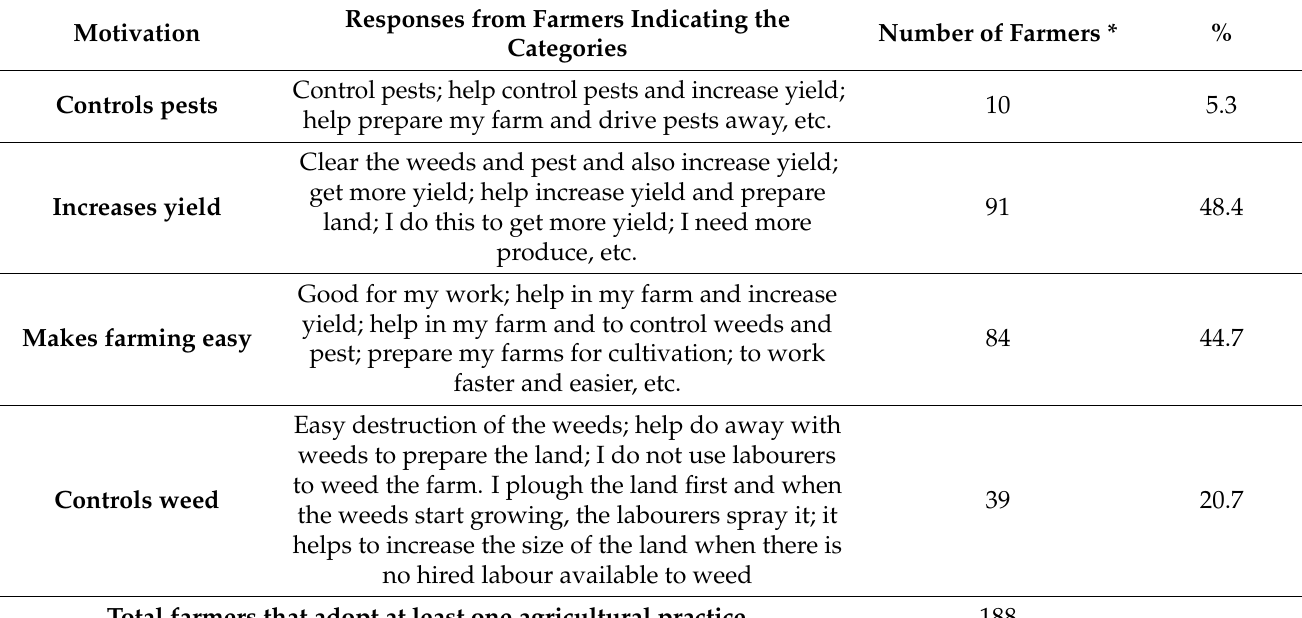
Table 4. Categorized perceptions for adoption based on farmers’ responses. * The number of farmers that adopt at least one agricultural practice is 188. The total for the categorized perception for adoption is 224 farmers because some farmers gave more than one response. The percentage is however out of 188 to reflect the responses against the number of farmers that adopt the